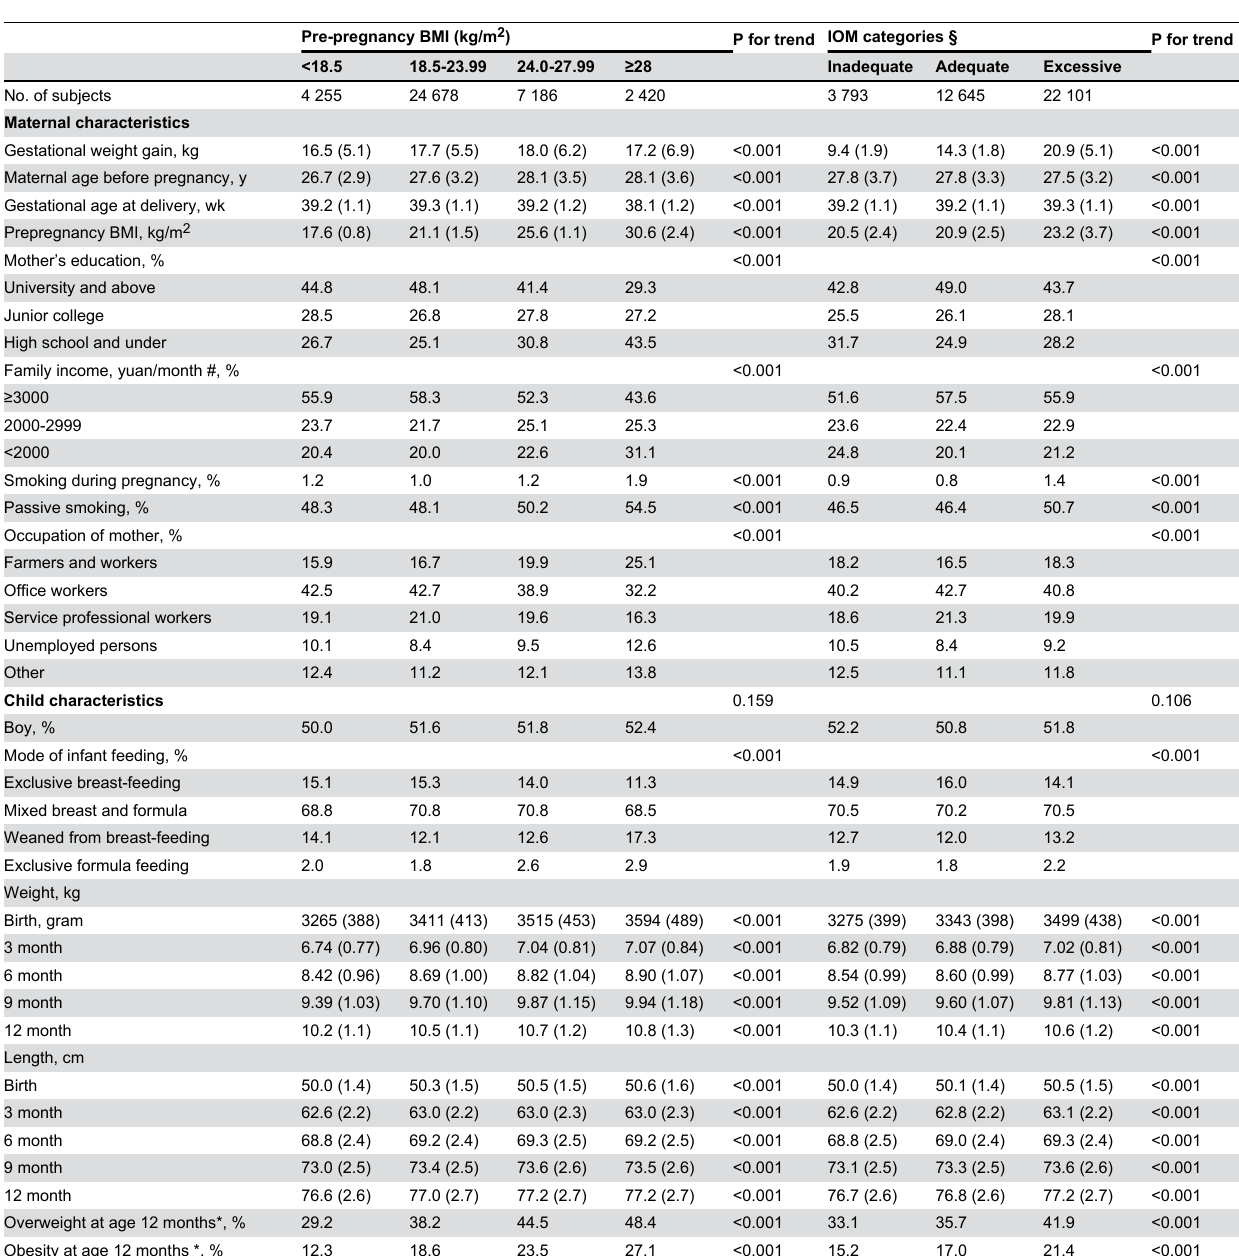
Table 1. Characteristics of study participants among 38 539 mother-infant pairs according to gestational weight gain categories in Tianjin,